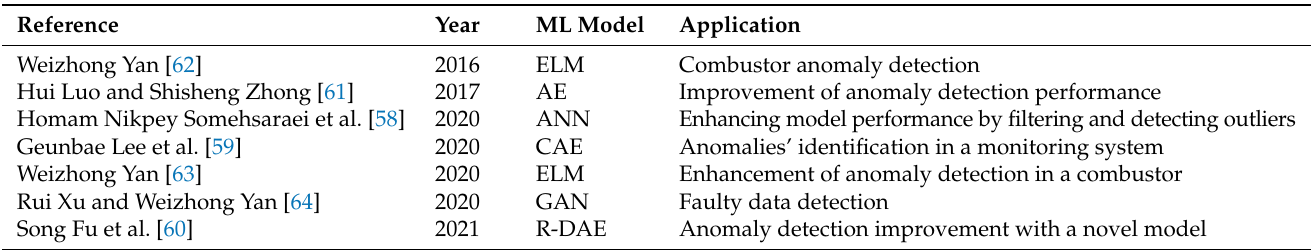
Table 2. Summary of the presented methods for anomaly detection using machine-learning models.